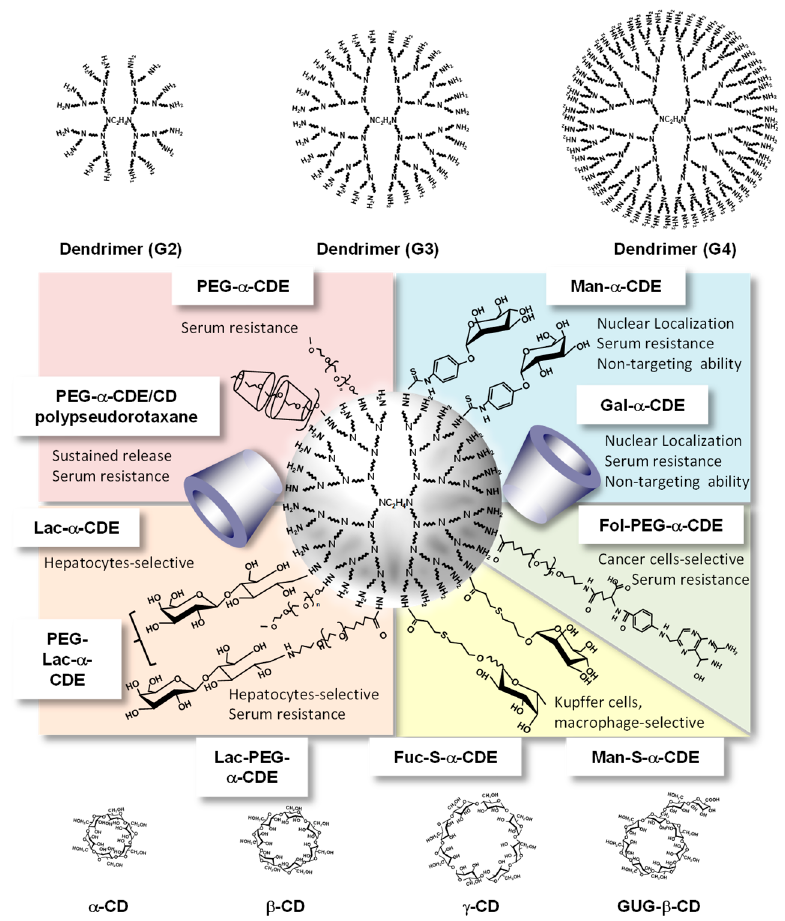
Figure 6. Chemical structures and properties of representative ligand-appended CDEs described in this review .